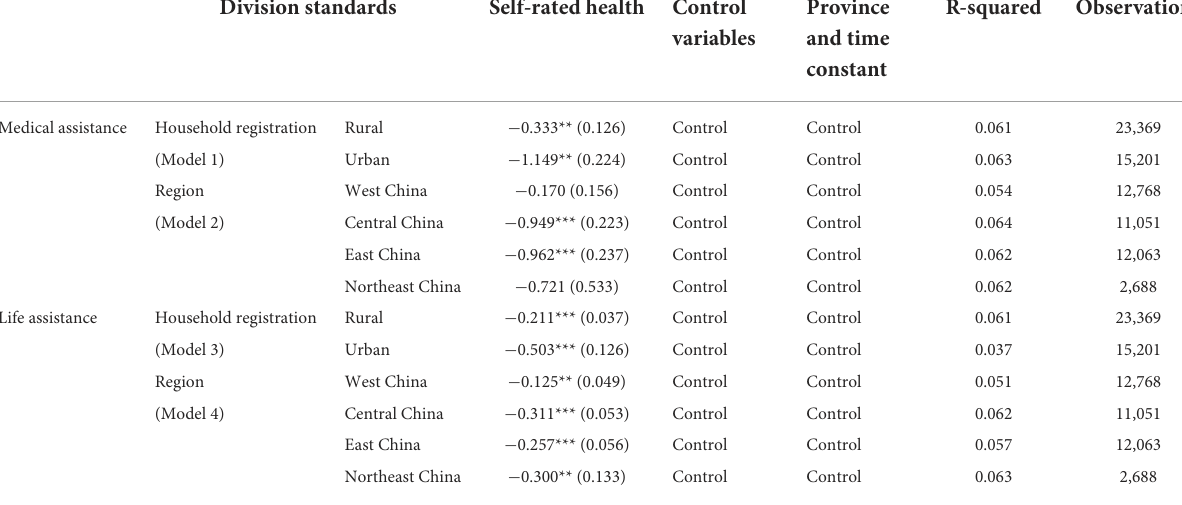
TABLE 6 Heterogeneity analysis under different division